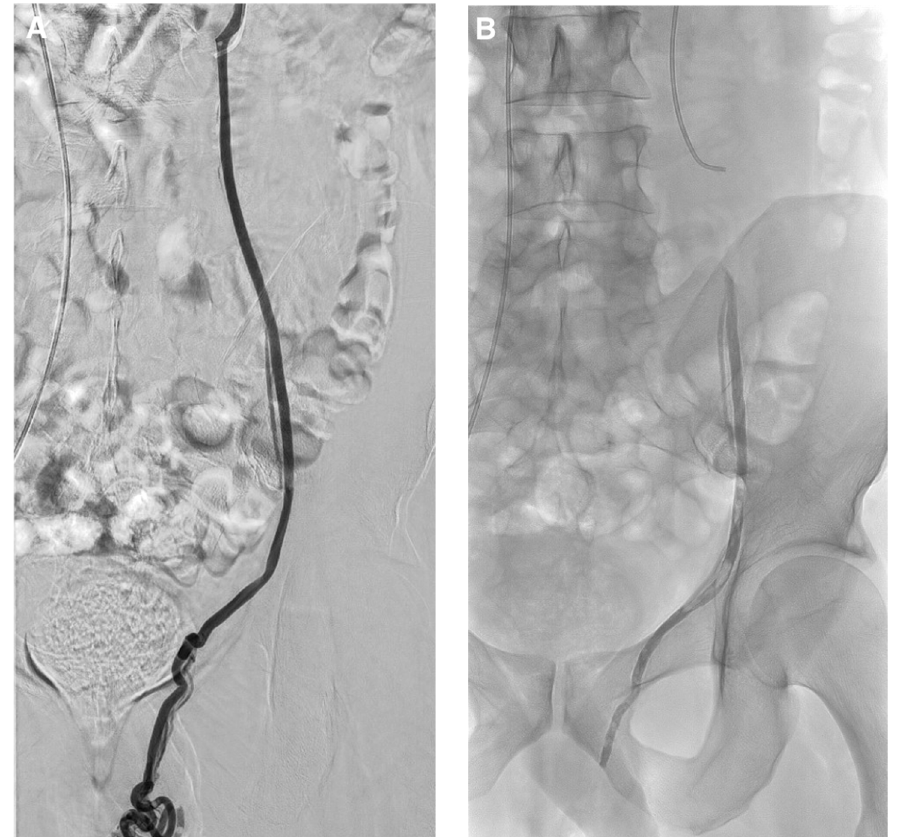
Figure 8. Typical left varicocele embolization with glue. ( A ) Left gonadal vein phlebography: a 5 French catheter is inserted in the left spermatic vein. A microcatheter is placed below the iliopectineal line and the dead space is filled with dextrose 5%, to avoid intracatheter glue polymerization. Embolization procedure is then performed using glue mixed with lipiodol at a ratio of 1:1 to get fast polymerization and avoid migration in case of reflux. Lipiodol–glue mixture is then injected under strict fluoroscopy, with continuous injection performed manually and a display of real-time distribution. The glue injection begins in the distal intrapelvic segment of the gonadal vein, and the catheter is withdrawn slowly while injecting NBCA under fluoroscopic control. Injection is then stopped before the pampiniform plexus is reached. The microcatheter is then removed when the glue fills the venous space selected beforehand. ( B ) Here we can see the cast of glue along the left spermatic vein after